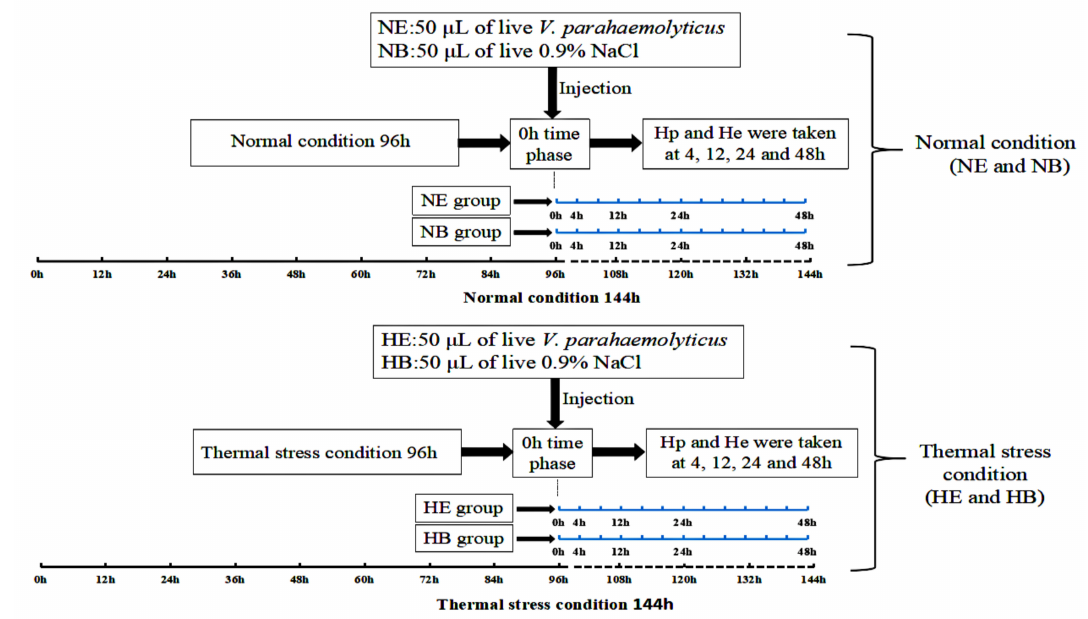
Figure 11. The frame chart of experiments in this study. Under the normal condition (25 ◦ C), two groups of animals were maintained for 96 h. After 96 h, NE group were injected with 50 µ L live V. parahaemolyticus (1.1 × 10 8 cfu/mL in 0.9% NaCl), NB group were injected with 50 µ L 0.9% NaCl. Under the thermal stress condition (30 ◦ C), two groups of animals were maintained for 96 h. After 96 h, HE group were injected with 50 µ L live V. parahaemolyticus (1.1 × 10 8 cfu/mL in 0.9% NaCl), HB group were injected with 50 µ L 0.9% NaCl. Hp and He were collected at time phases 4, 12, 24 and 48 h. Values are means ± SD of biological replicates ( n = 6). HE: thermal stress and injected V. parahaemolyticus , HB: thermal stress and injected NaCl. NE: normal condition and injected V. parahaemolyticus , NB: normal condition and injected NaCl. Hp: